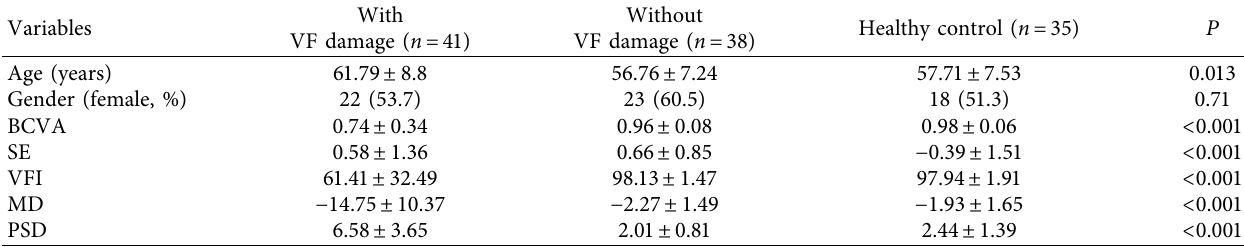
Table 1: Characteristics of participants with or without visual feld damage.